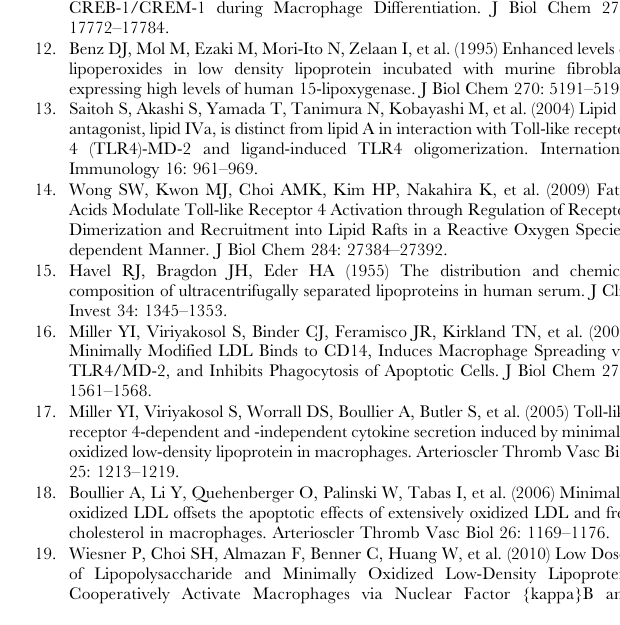
Figure S2 Lack of p65 phopshorylation in response to mmLDL. WT and Syk 2 / 2 BMDM were incubated with media or mmLDL (50 m g/ml) for 15 min. Cell lysates were separated on SDS-PAGE and immunoblotted with antibodies against phospho- p65 and GAPDH. Figure S3 Role of JNK, IKK e and ERK1/2 in phosphor- ylation of c-Jun and c-Fos in mmLDL-stimulated mac- rophages: Quantification of results presented in Fig. 2C.